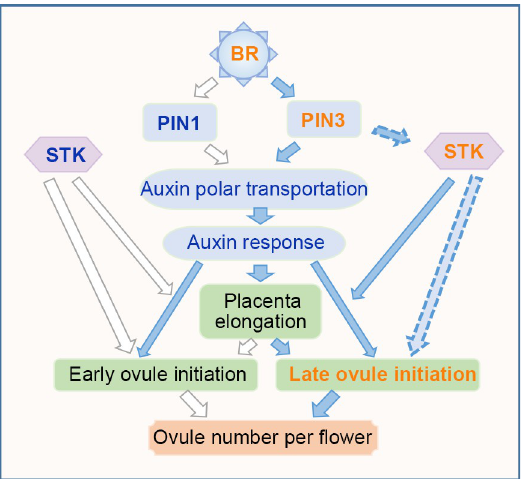
Fig 8. Proposed model for the ovule number determination in Arabidopsis. Ovule number per flower is determined by the early and late ovule initiation processes, while the early ovule initiation process has been demonstrated previously that partially controlled by BR-PIN1 pathway. Here, we discovered the late ovule initiation process mainly through BR-PIN3 pathway. BR positively regulates PIN3 expression which in turn is required for auxin polar transport to form an auxin maxima in the placenta for ovule primordia initiation. Moreover, PIN3 indirectly regulates STK expression, which is required for pistil growth and ovule identity, to promote pistil elongation providing enough space for the late ovule